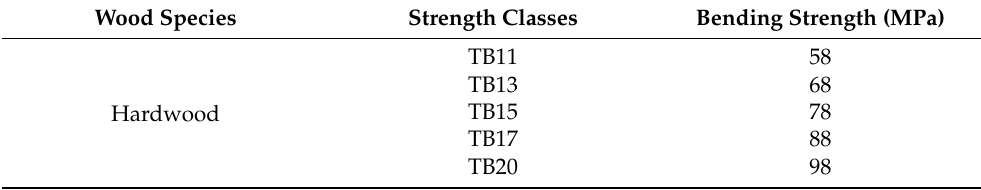
Table 1. Strength classes of structural hardwood according to Chinese standard GB 50206. Wood